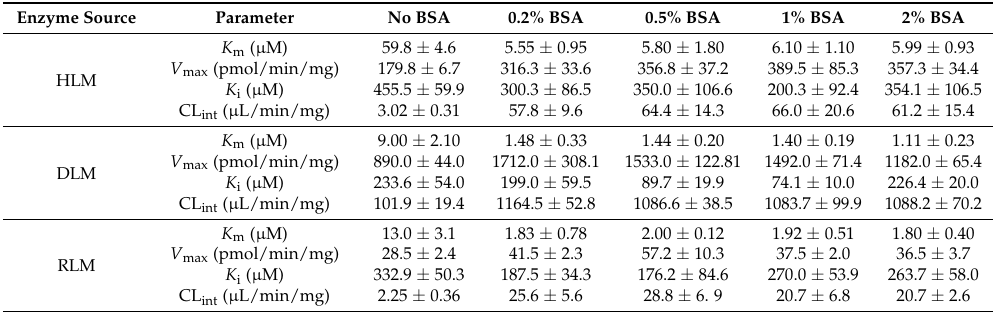
Figure 3. Atypical kinetic profiles for Ib glucuronidation in RLM ( A ), DLM ( B ) and HLM ( C ), in the absence and presence of BSA. Inset, Eadie-Hofstee plots for each of the profiles are shown. In the concentration of BSA at 0%, 0.2% and 0.5%, incubations were performed across 10 to 800 µ M Ib concentration range. In the concentration of BSA at 1% and 2%, incubations were performed across 10 to 2000 µ M Ib concentration range. The substrate concentration ([S]) in kinetic profiles refers to the unbound Ib concentration corrected by the free fraction ( f u ) of Ib. Each data point represents mean ± S.D. of triplicate determinations. Table 2. Kinetic parameters of Ib glucuronidation in liver microsomes in the absence and presence of BSA. ( n = 3, mean ± S.D.).